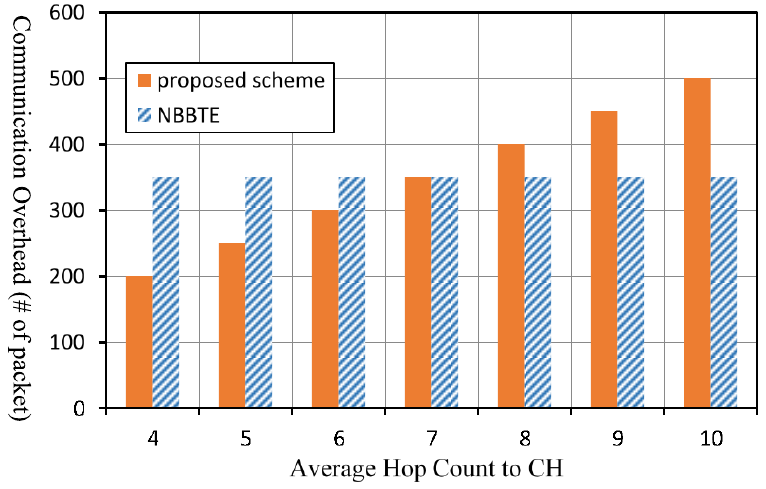
Figure 12. Comparison of the communication overhead under different average of hop count to the CH.